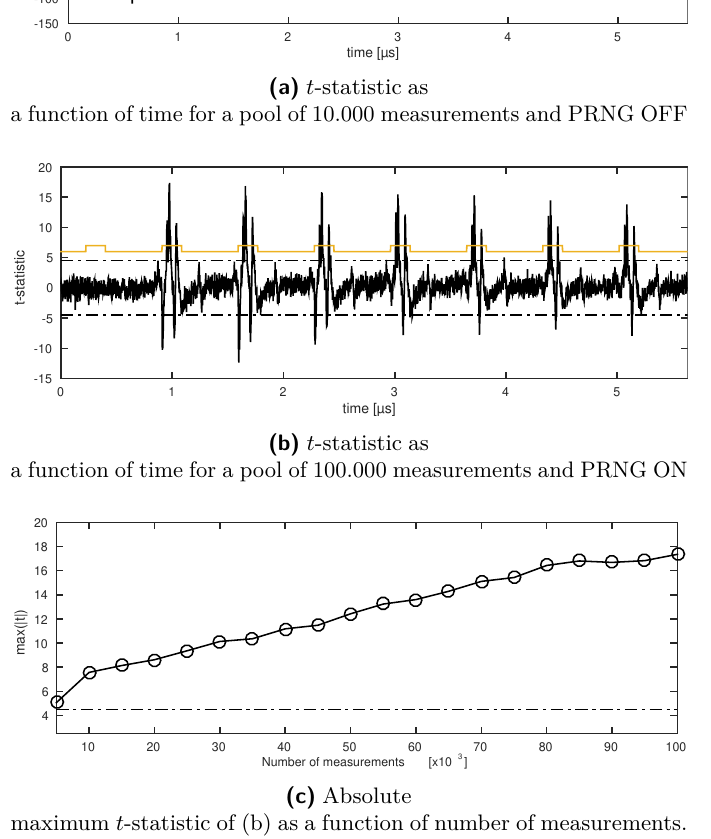
Figure 2: TVLA of Debraize’s A2B